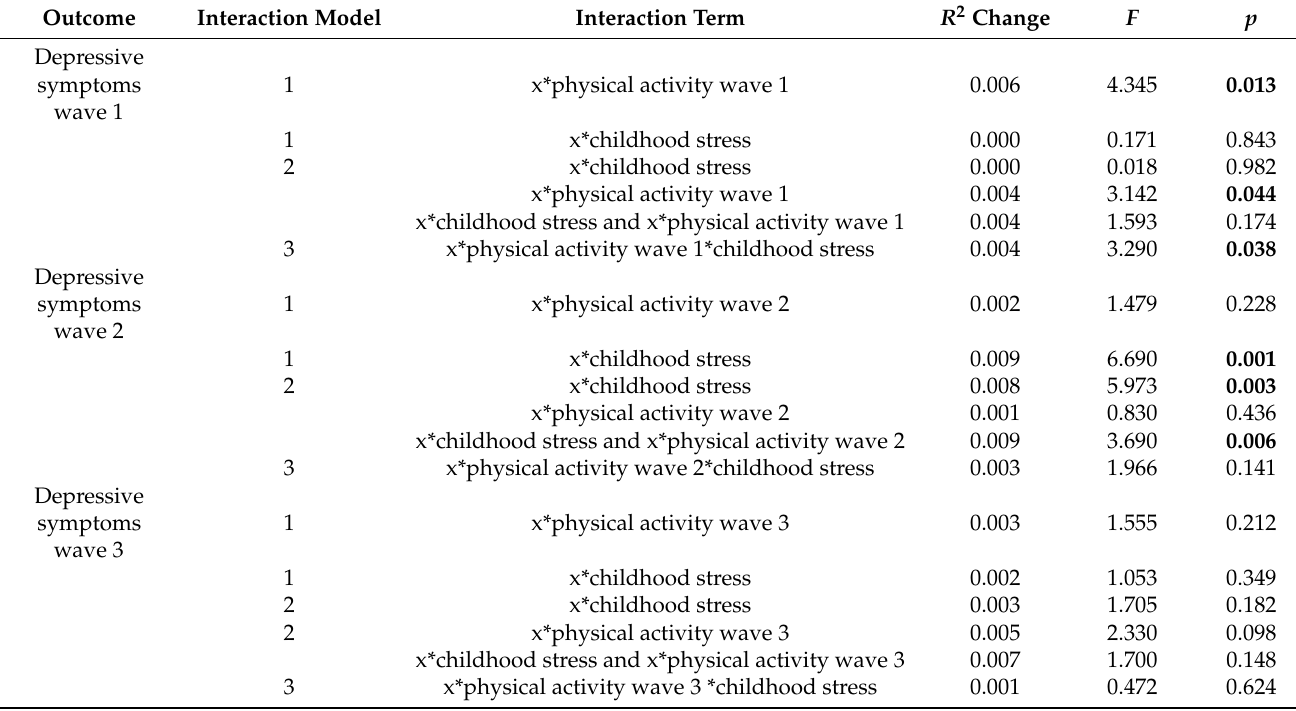
Table 4. Test of highest order of unconditional interactions using Process.